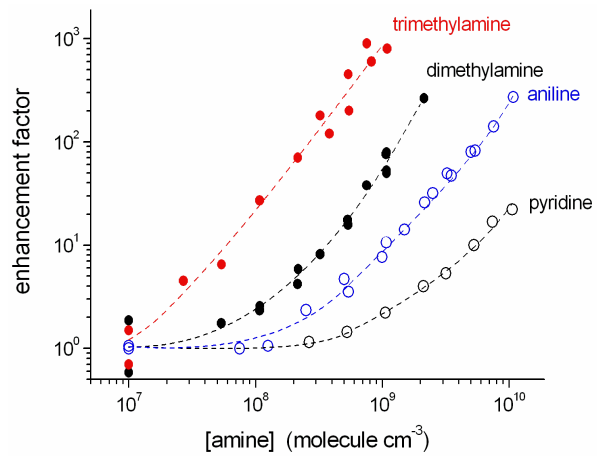
Fig. 7. Enhancement factors, N amine added /N w/o amine addition , for trimethylamine, dimethylamine, aniline and pyridine detected at RH = 13% for [H = 2 × 10 8 moleculecm − 3 , PSM measurements 2 SO 4 ] for a diameter ≥ ca.